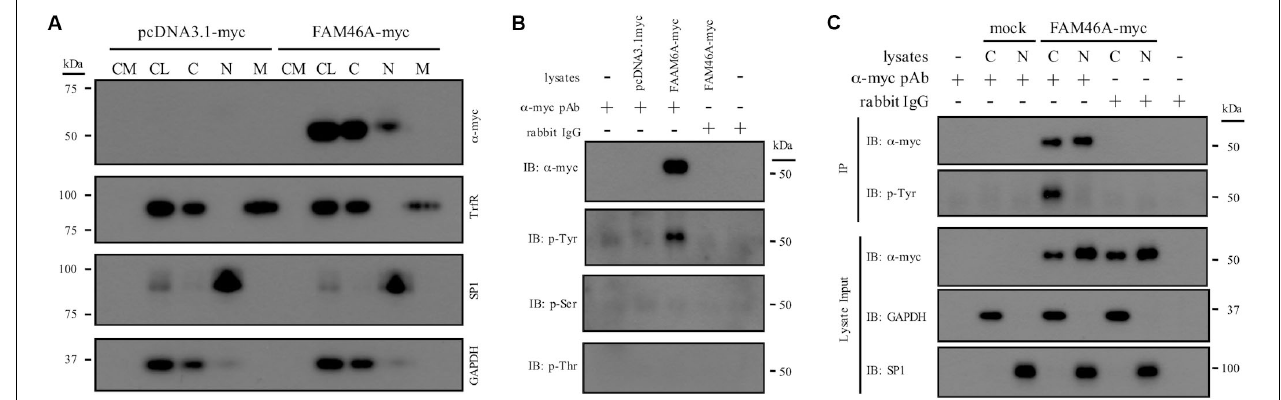
FIGURE 2 | Subcellular distribution and biochemical characterization of the FAM46A protein. (A) HeLa cells were transfected with the expression constructs as indicated. Conditioned medium (CM) and total cell lysate (CL) were collected 48 h post-transfection. In addition, protein samples from the cytosolic (C), nuclear (N), and membrane (M) fractions were obtained following the standard subcellular fractionation procedure. Protein samples were separated on SDS-PAGE and subjected to Western blot analysis using specific Abs as indicated. (B) Cell lysate of HeLa cells transfected with the indicated expression constructs was immunoprecipitated by polyclonal anti-myc Abs and subjected to Western blot analysis using specific Abs as indicated. Normal rabbit IgGs were included as a control of the polyclonal anti-myc Abs. (C) The cytosolic (C) and nuclear (N) protein samples collected from transfected HeLa cells were immunoprecipitated by polyclonal anti-myc Abs and subjected to Western blot analysis using specific Abs as indicated. The top three panels were the lysate input controls. The data shown were the representatives of three separate